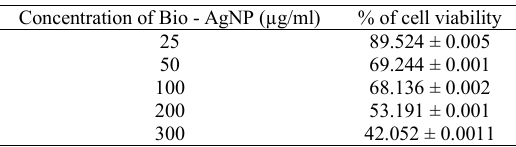
Table 4 MTT assay of Bio – AgNP on cultured L929 fibroblast cells Table 4. MTT assay of Bio – AgNP on cultured L929 fibroblast Concentration of Bio - AgNP (µg/ml)